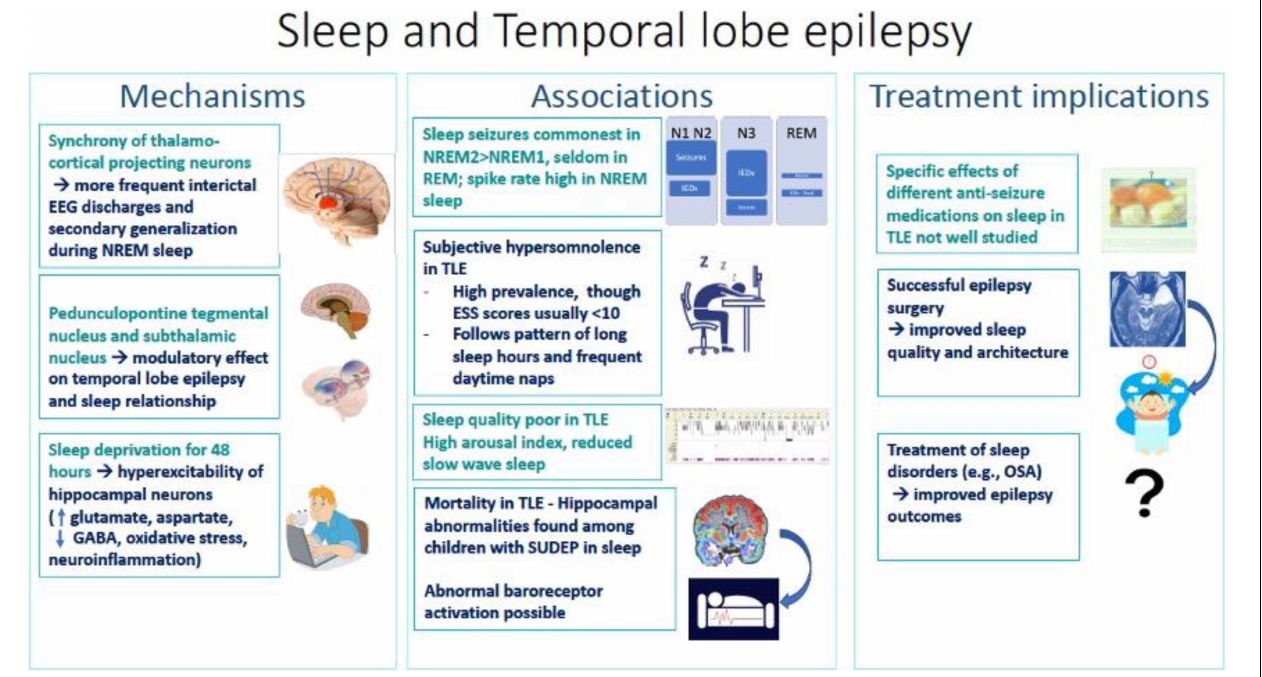
FIGURE 1 | Summary diagram of associations, mechanisms and treatment implications of sleep and temporal lobe